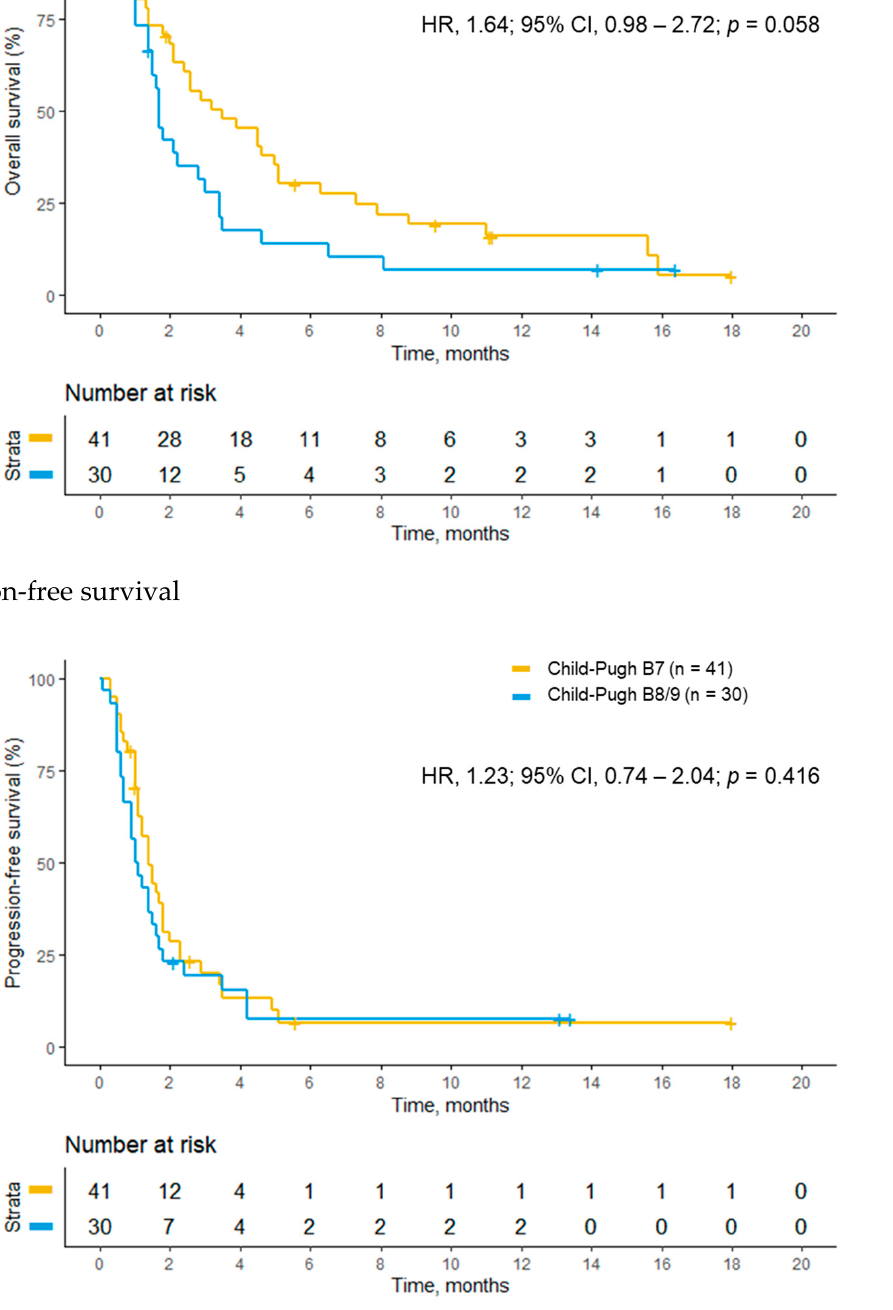
Figure 2. Kaplan–Meier analyses of survival outcomes between Child–Pugh B7 and B8/9 patients. ( A ) overall survival and ( B ) progression-free survival.